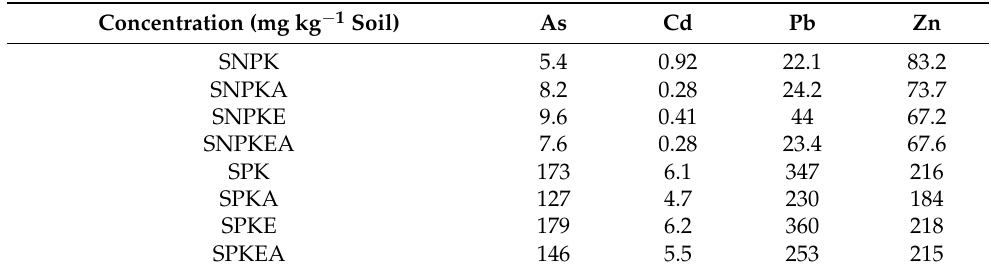
Table 1. Heavy metal (As, Cd Pb, and Zn) concentration (mg kg − 1 soil) in different layers of mixed soil after cultivation of K. pentacarpos in the presence and absence of NaCl or/and EDDS for 5 months. The sample was tested once.